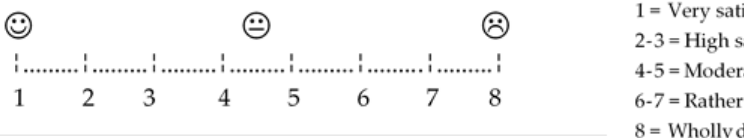
Figure 1. Likert-type scale with 5 score ranges. Stress Scale.